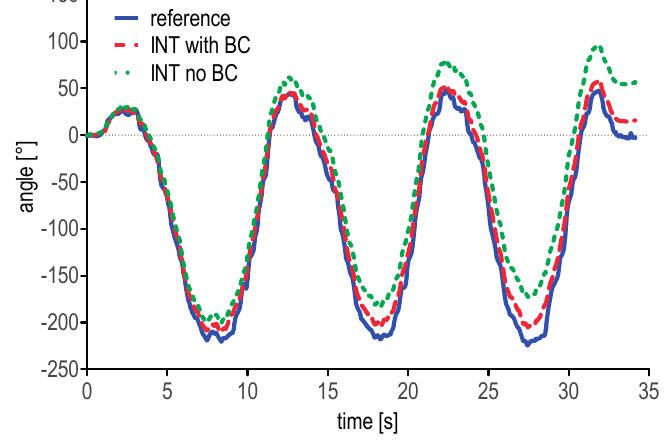
Figure 6. Heading angle as obtained during three complete “figures of eight” of one randomly selected locomotion trial. Angles obtained by the stereophotogrammetric system (solid line), and by numerical integration with (dashed line) and without (dotted line) bias correction (BC) are